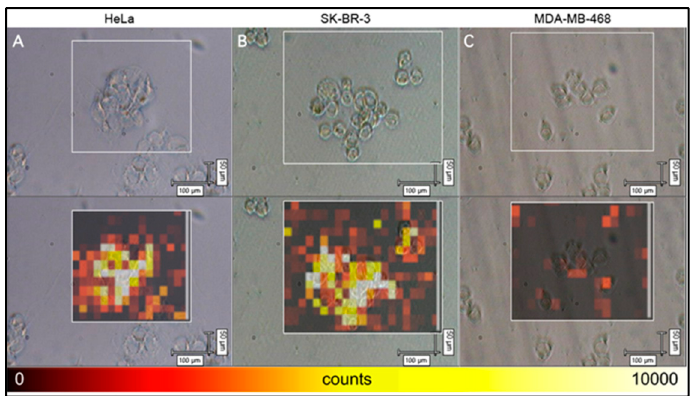
Figure 4. Raman mapping of the three different cell lines after 4 h incubation with the FA-targeted theranostic nanoparticles at 0.1 nM concentration. The sample was scanned in a grid pattern with 20 µm step size, taking a 1 s acquisition at each point. The Raman peak intensity at each point was then integrated to create the false-color Raman map that is overlaid on the bright field image. Raman maps correspond to 2 FR-positive cell lines, HeLa ( A ), and SK-BR-2 ( B ), and a FR-negative cell line, MDA-MB-468 ( C ). The FR-positive cell lines show high Raman intensity coming from the cluster of cells, whereas the FR-negative cell line shows little to no Raman signal. Scale bars are X = 100 µm and Y = 50 µm. Adapted from [46].